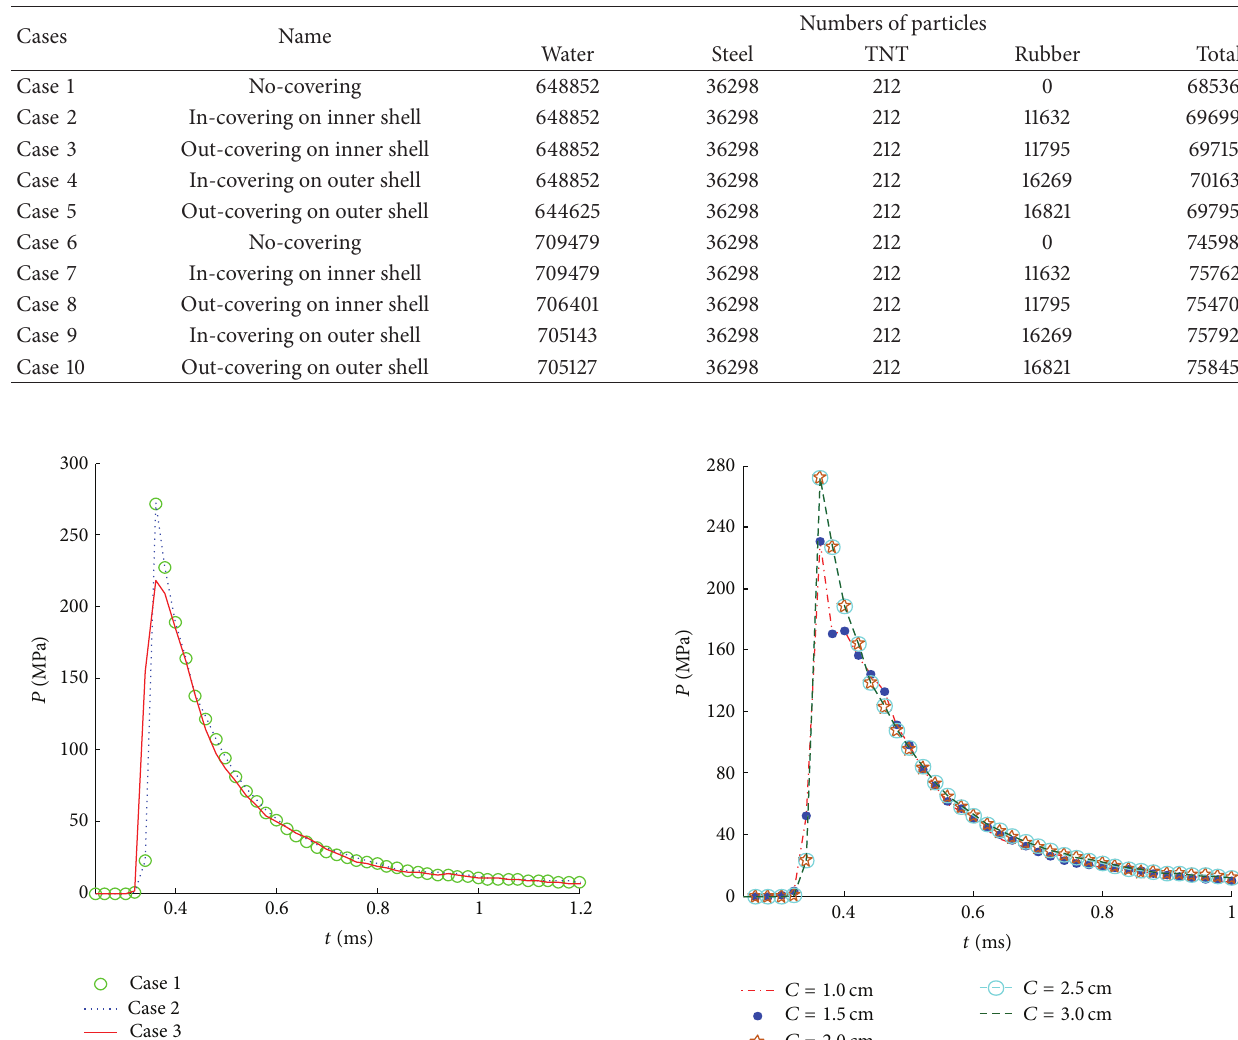
Table 10: Different cases of double cylindrical shell (Cases 1–5 belong to the case of double-hull without interlayer water; Cases 6–10 belong to the case of double-hull full of interlayer water).